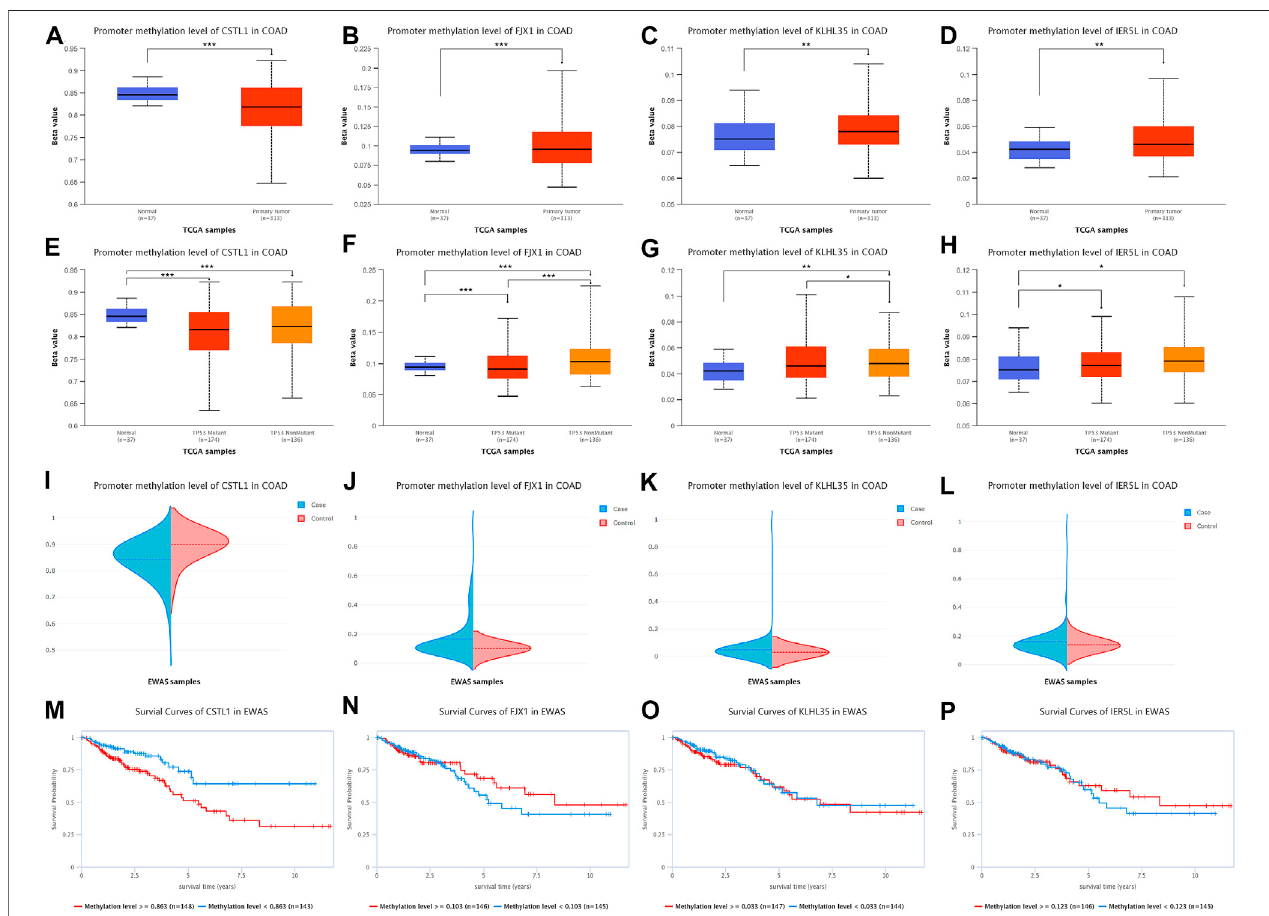
FIGURE 6 | DNA methylation levels of prognostic genes. (A – D) Promoter methylation levels of CSTL1, FJX1, KLHL35, and IER5L in colorectal cancer. (E – H) Promoter methylation levels of CSTL1, FJX1, KLHL35, and IER5L in colorectal cancer with different TP53 mutation status. (I – L) DNA methylation of the genes was validated in the EWAS database, the same as the UALCAN database. (M – P) Survival analysis of the promoter methylation levels of different genes.